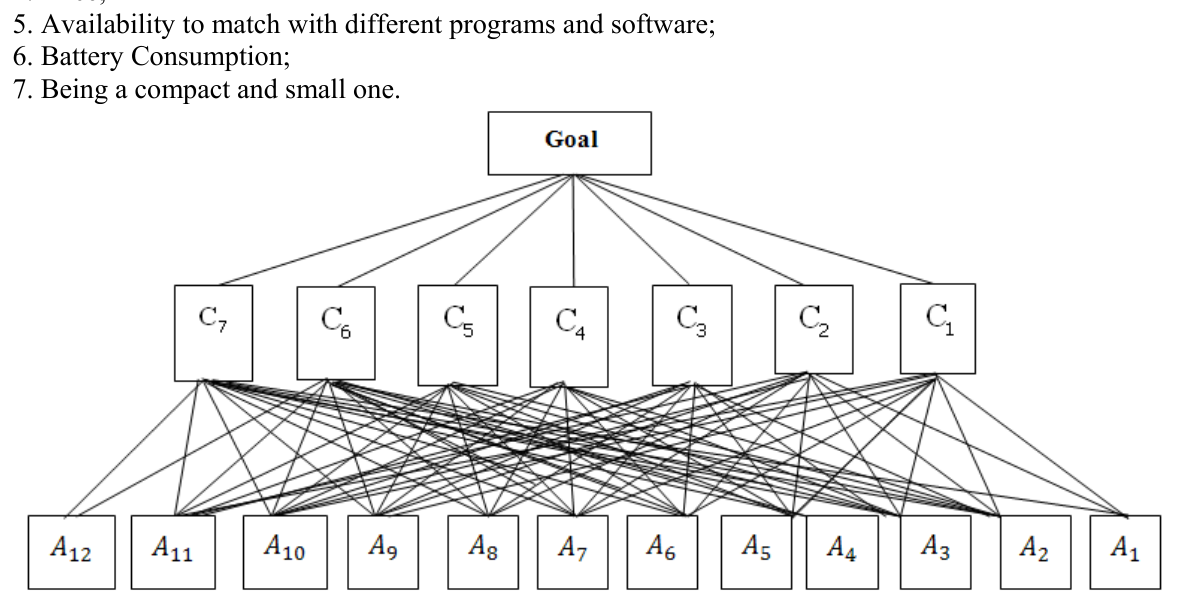
Fig. 3. The general model of evaluation